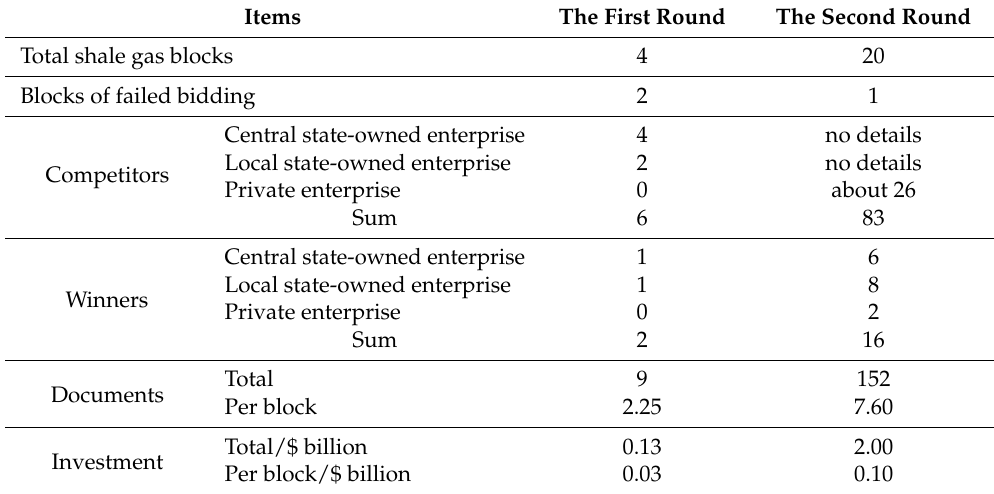
Table 3. The comparison between the first and the second round of